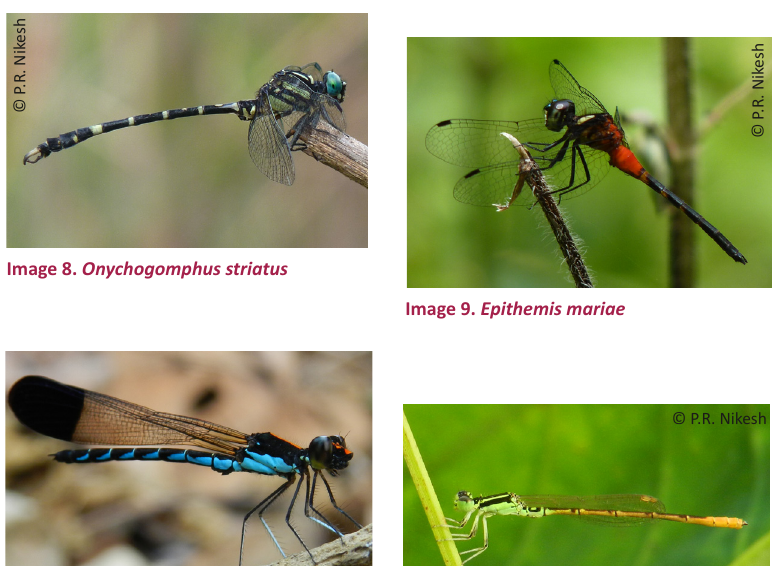
Image 11. Calocypha